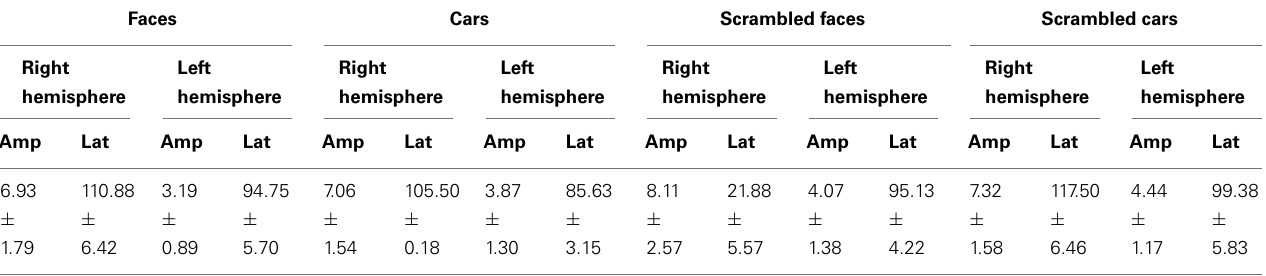
Table 3 | Mean amplitude and latency values of P1 component for